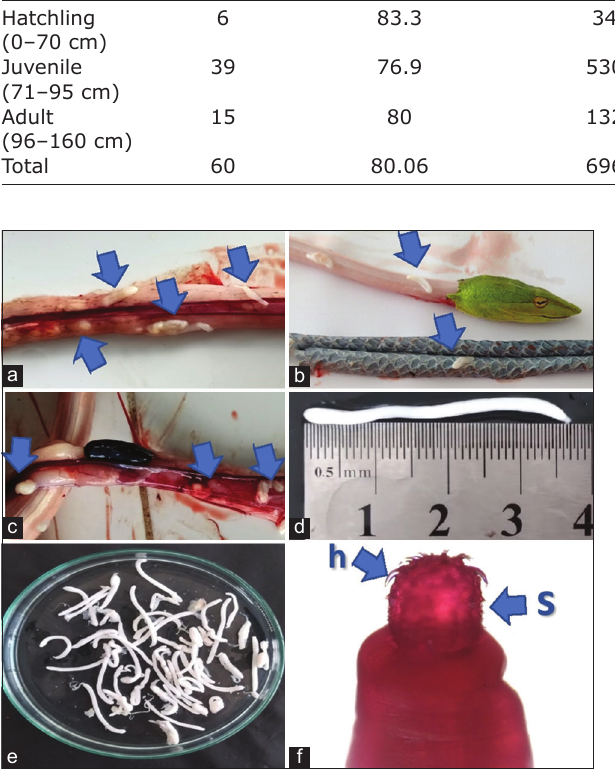
Figure-1: Acanthocephalan parasite in Asian vine snakes ( Ahaetulla prasina ). (a) Acanthocephalan in muscles (arrow), (b) subcutaneous tissue (arrows), (c) viscera (arrows). (d and e) Macroscopic appearance of acanthocephalan. (f) Photomicrographs of acanthocephalan anterior end illustrate proboscis with hooks (h arrow) and proboscis spine (s arrow) (Carmine staining, magnification, 100×)